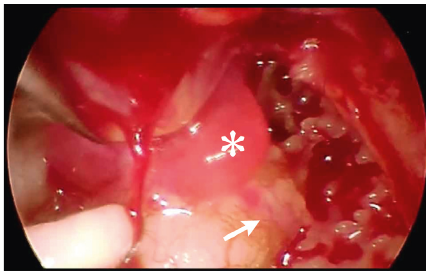
Figure 2: Findings seen during transcanal endoscopic ear surgery. The reddish tumor (asterisk) was located on the promontory. The tumor feeder was identified as the inferior tympanic artery